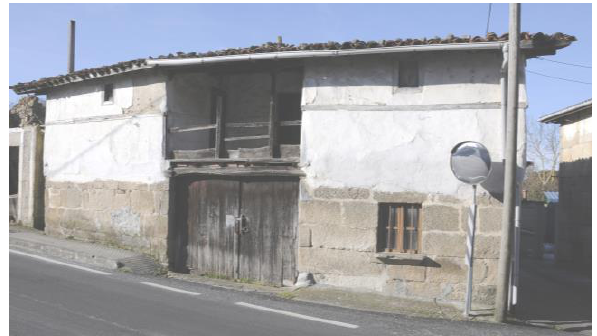
Figure 4. Rural house near the settlement of Maceda with half- timbered with earth floor. Source: A.F.P.